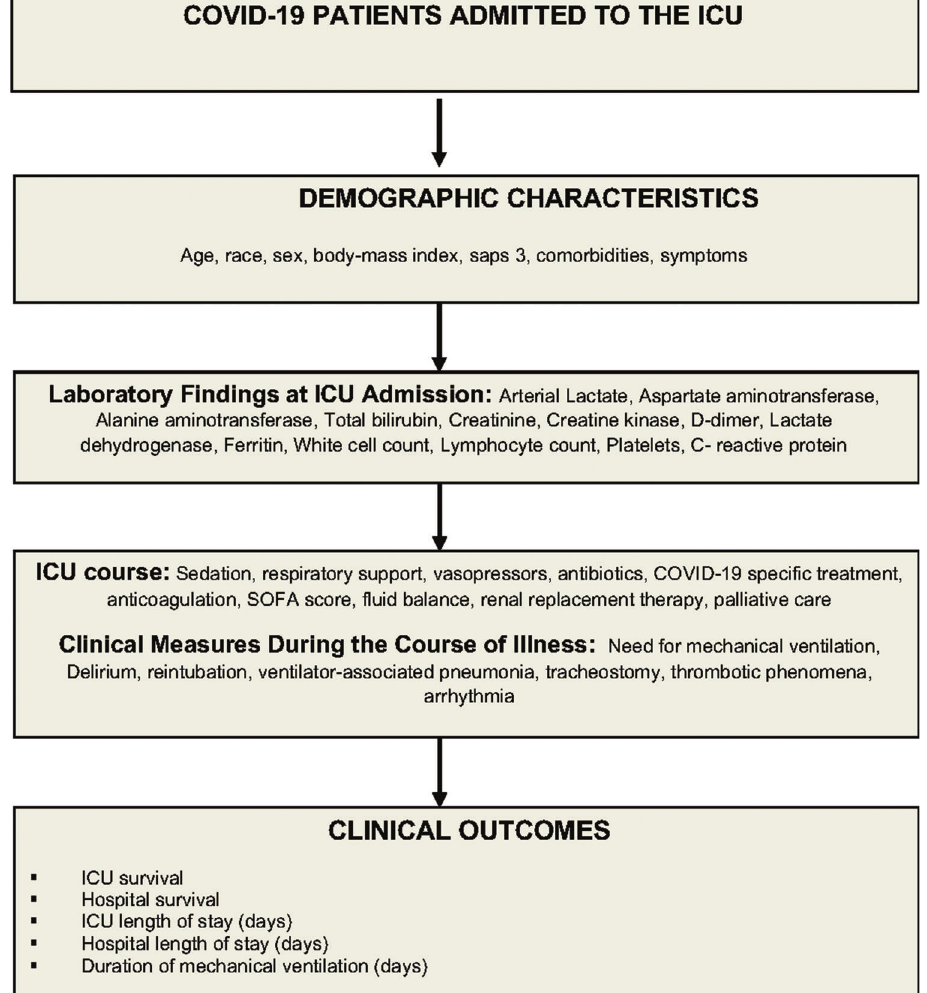
Figure 2 - Overview of data collection and follow up in the